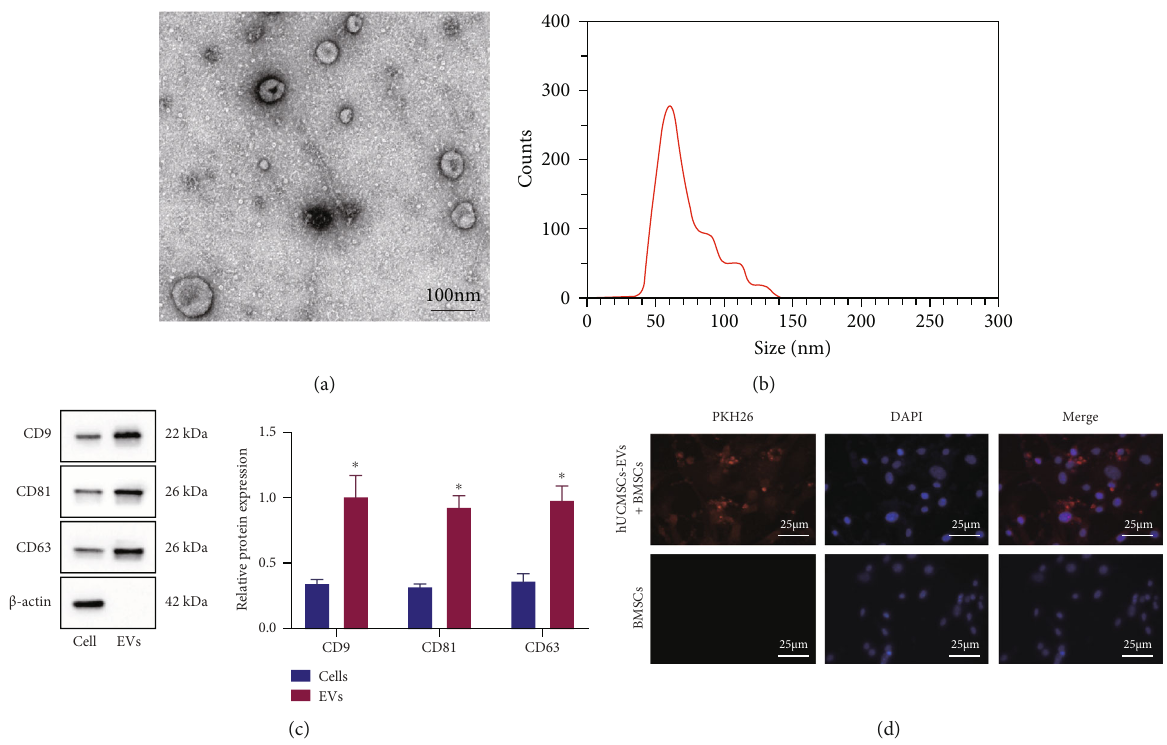
Figure 1: Isolation and identi fi cation of hUCMSC-EVs and observation of uptake of EVs by BMSCs. (a) EV morphology observed under the TEM ( scale bar = 100 μ m ). (b) EV particle size distribution detected by NTA. (c) The expression of CD9, CD81, CD63, and β -actin in hUCMSCs and hUCMSC-EVs measured by Western blot analysis. (d) After PKH26 labeling of hUCMSC-EVs, uptake of EVs by BMSCs was observed under fl uorescence microscopy ( scale bar = 25 μ m ). ∗ p < 0 : 05 , compared with